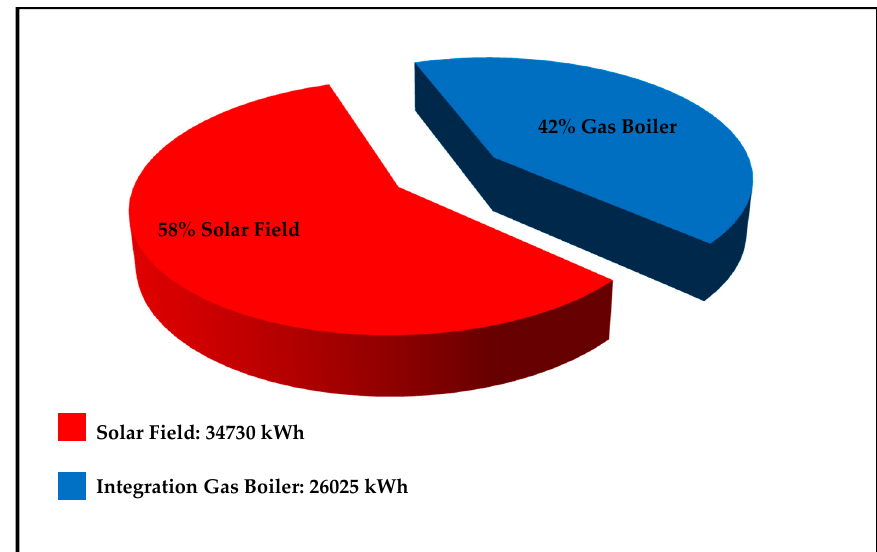
Figure 7. Solar coverage during cooling season.